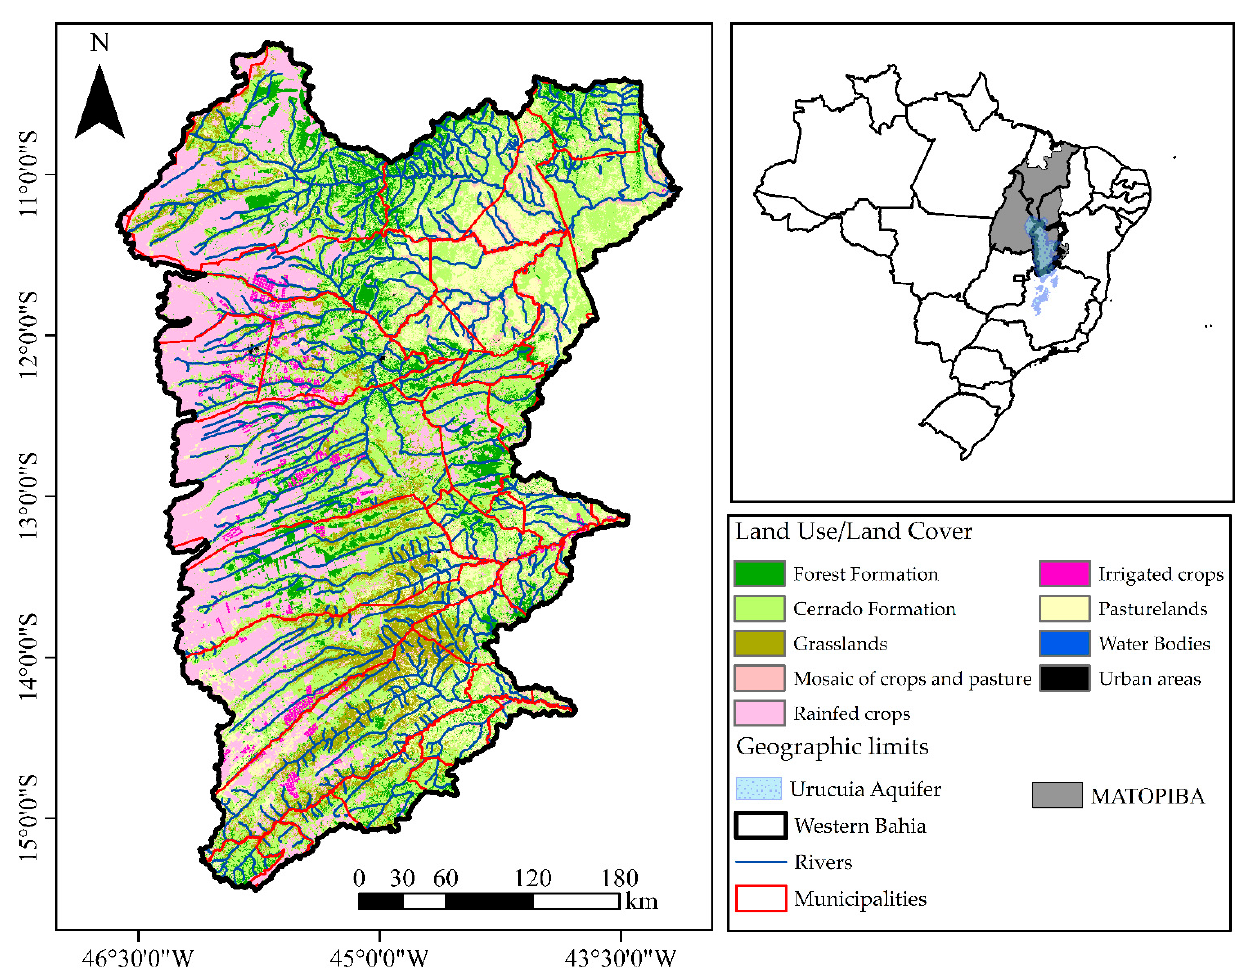
Figure 2. Location and land use/land cover for Western Bahia in 2019, according to Pimenta et al. [7] and available at: http://obahia.dea.ufv.br/ (accessed on 1 June